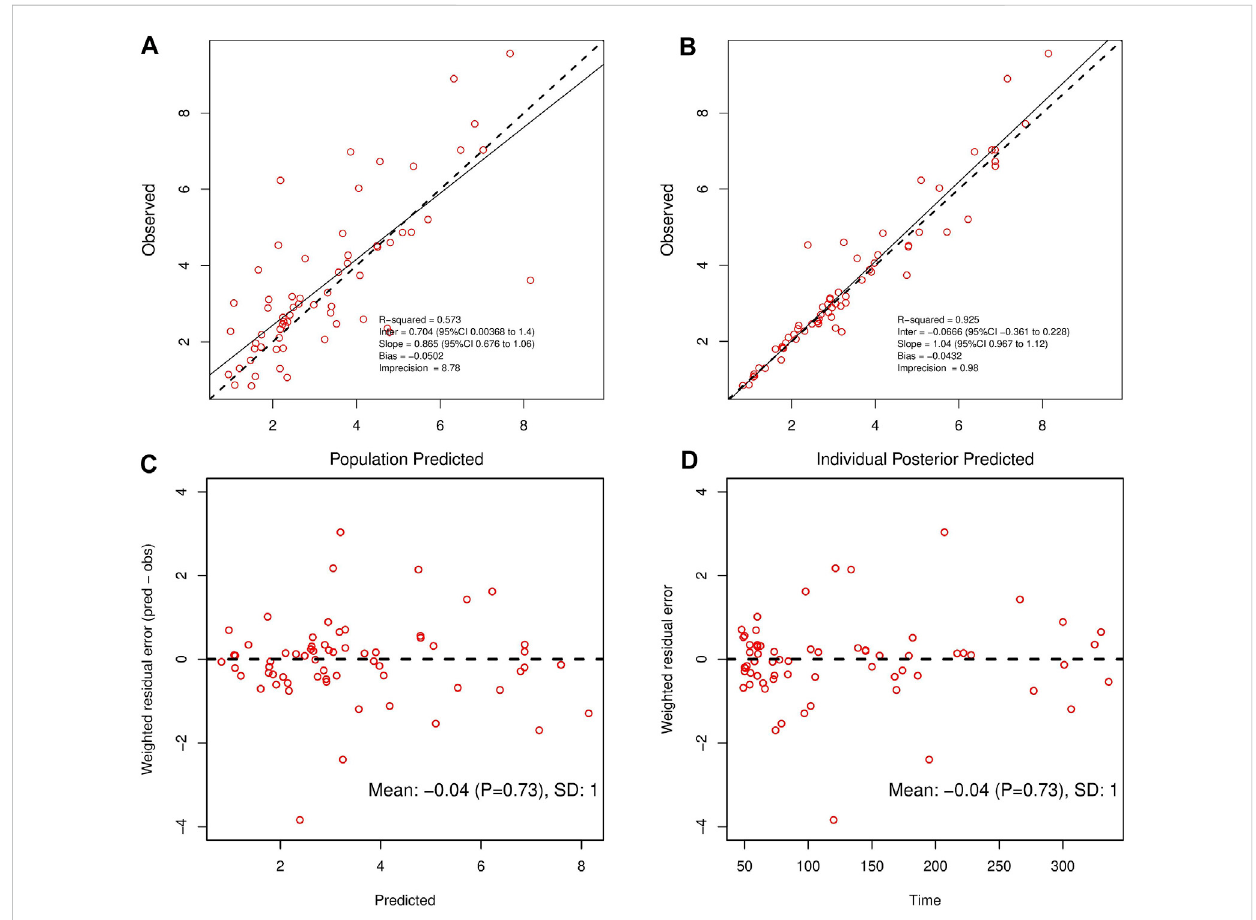
FIGURE 2 Observed concentrations versus Population Predicted (A) and Individual Posterior Predicted (B) . Weighted residuals plotted against predicted concentrations (C) ; Weighted residuals plotted against time post-administration (D)